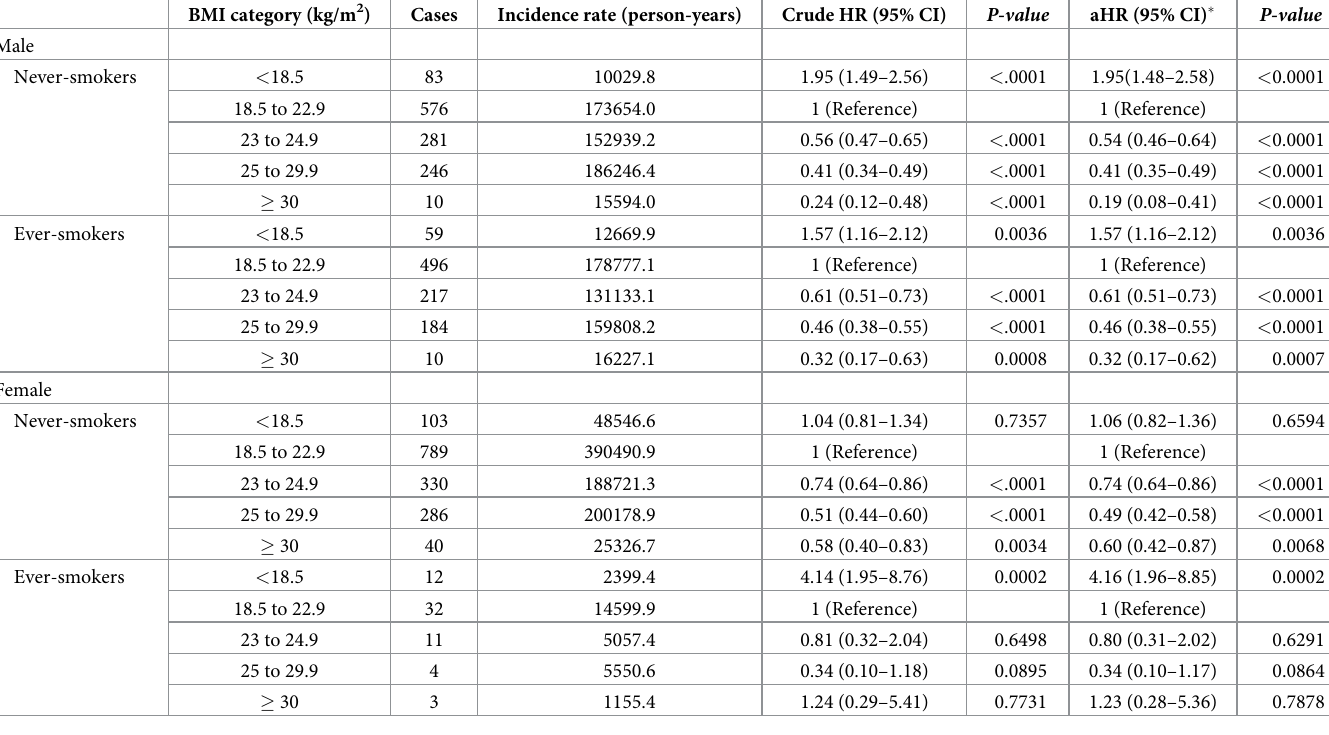
Table 4. Effect of BMI: Subgroup analysis by sex and smoking